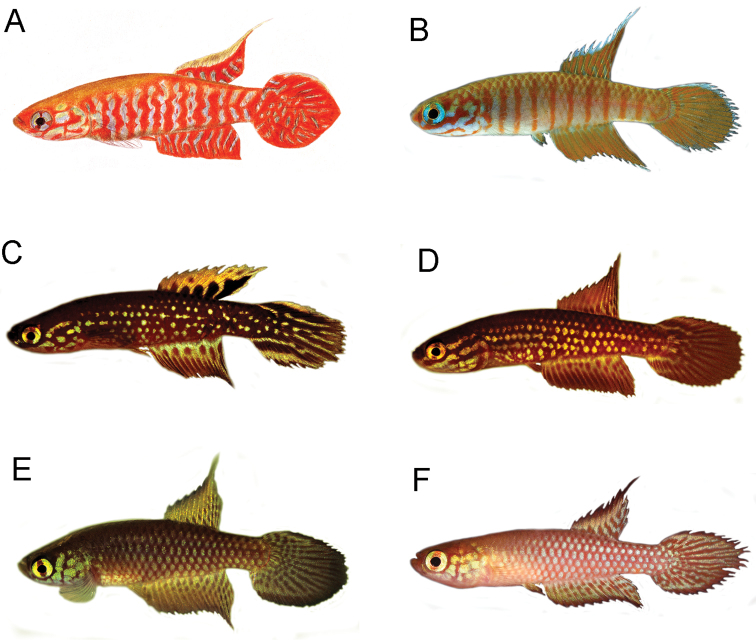
Male fin morphology and life colour patterns in Leptopanchax. A coloured pencil drawing illustrating L.
sanguineus sp. nov. in life, about 20 mm SLBL.
splendens, UFRJ 6902, 22.7 mm SLCL.
aureoguttatus, UFRJ 6331, 22.3 mm SLDL.
itanhaensis, UFRJ 6453, 20.7 mm SLEL.
citrinipinnis, UFRJ 8899, 20.6 mm SLFL.
opalescens, UFRJ 8986, 20.2 mm SL.